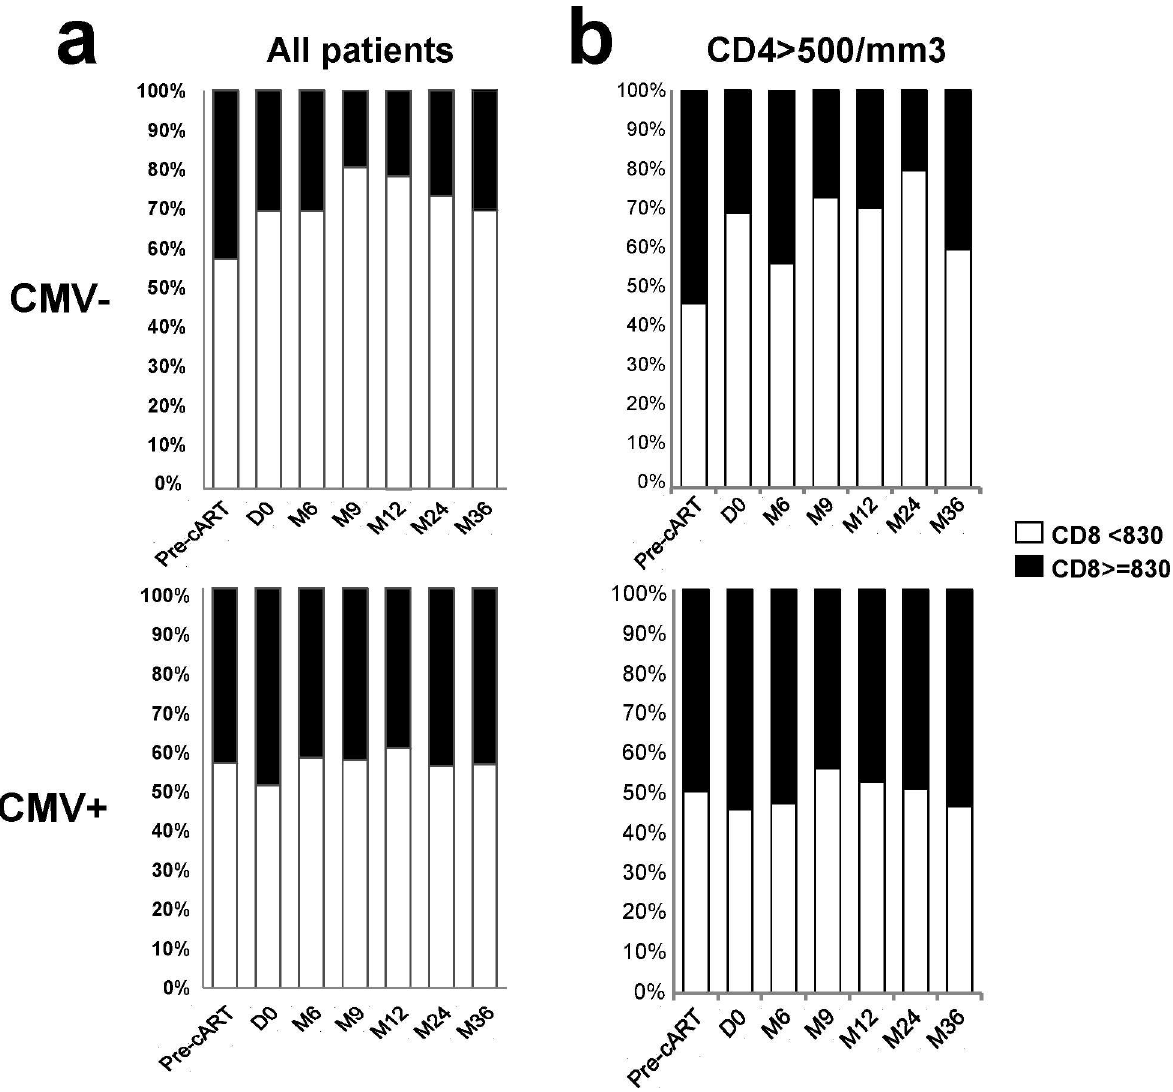
Fig 2. Longitudinal analyses of CD8+ T cell counts in CMV- and CMV+ HIV-infected patients on first-line cART. 100% stacked bar charts illustrate the fraction of patients displayingCD8+ T cell counts (cid:21) 830/mm3 (black) and < 830/mm3 (white) among all study participants (a) or in patients achieving CD4+ T cell count (cid:21) 500/mm3 after 12 months of HIV suppression on cART (b) in CMV- (top) and CMV+ (bottom)